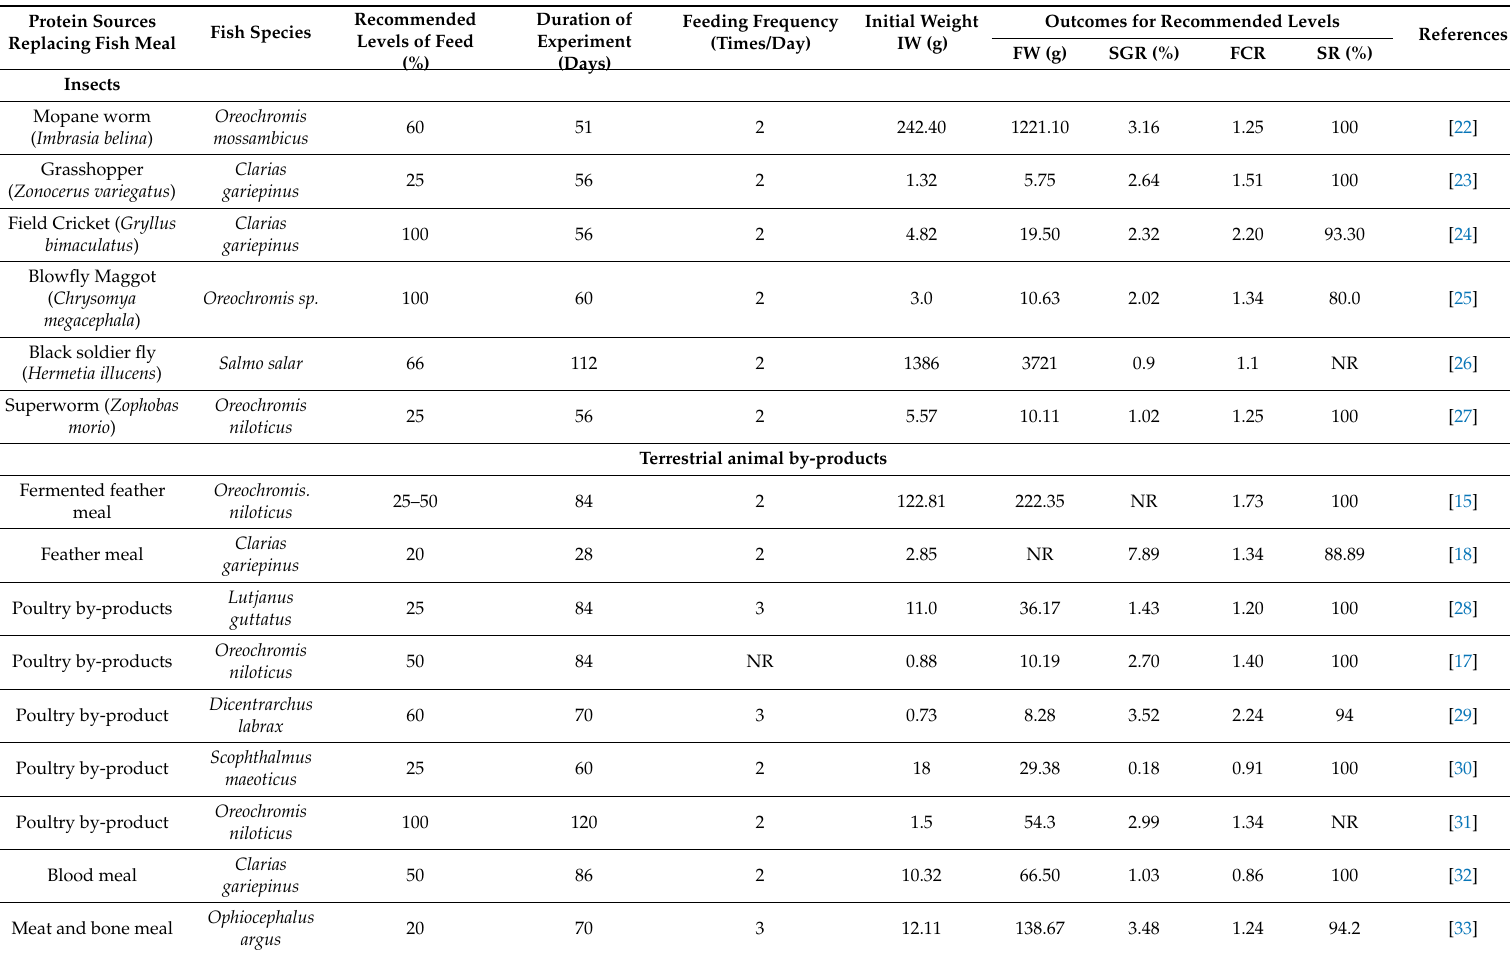
Table 1. Summary of studies that assessed animal protein sources as a fishmeal replacement in fish diets in aquaculture. Final weight (FW in grams), specific growth rate (SGR in percentage (%)), feed conversion ratio (FCR), and survival rate (SR in %) were used as the assessment parameters to measure